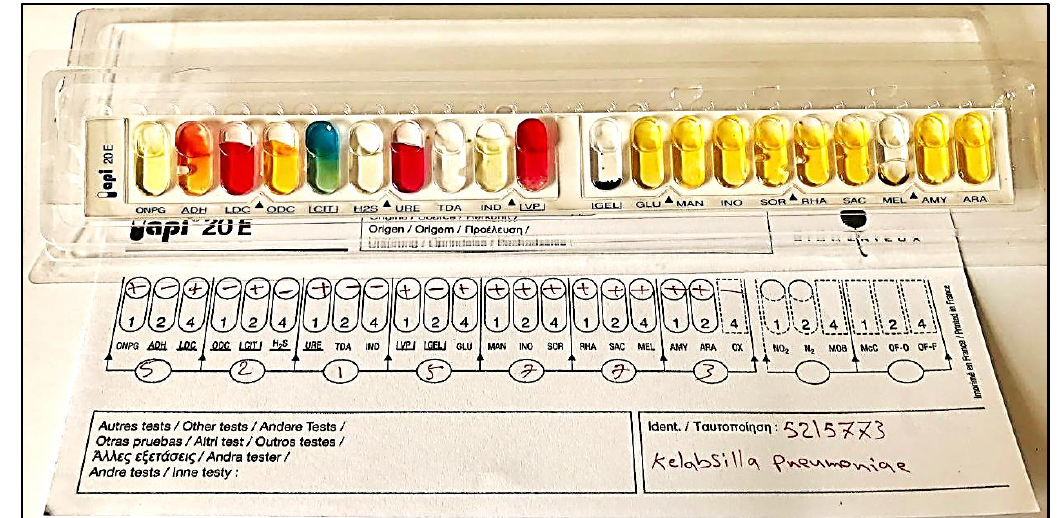
Fig. 6. The API 20 E positive result for K. pneumoniae isolate no. 45